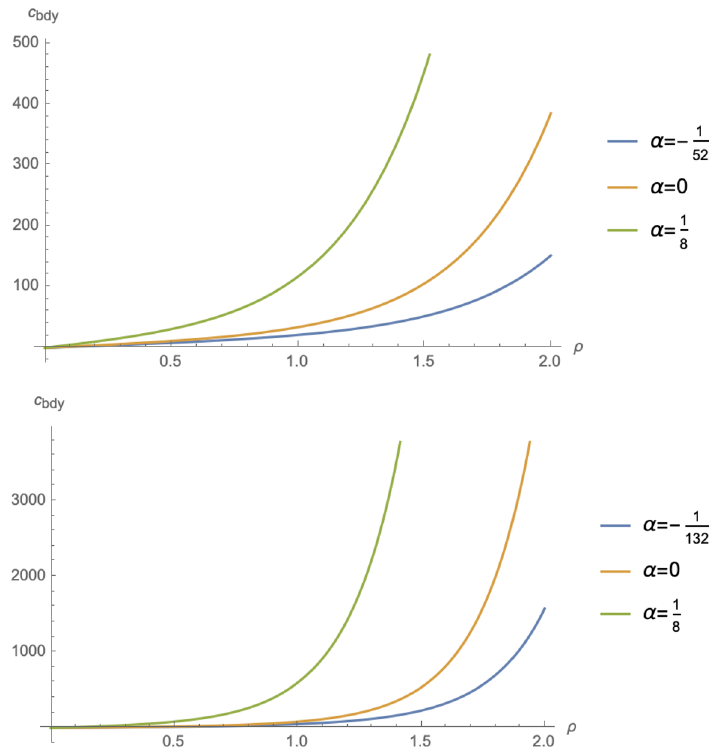
Figure 4 . A-type boundary central charge c bdy for d = 5 (above) and d = 7 (below). The blue line, orange line and green line correspond to the lower bound, zero and the upper bound of the Gauss-Bonnet coupling α . A-type boundary central charge c bdy is positive for ρ > 0 and increases with ρ . The larger α is, the larger the A-type boundary central charge